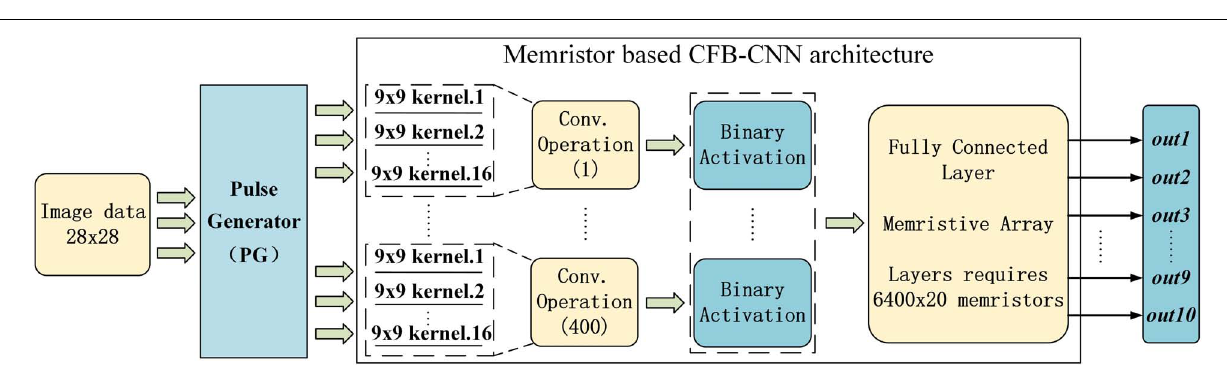
FIGURE 3 | Data flow of CFB-CNN